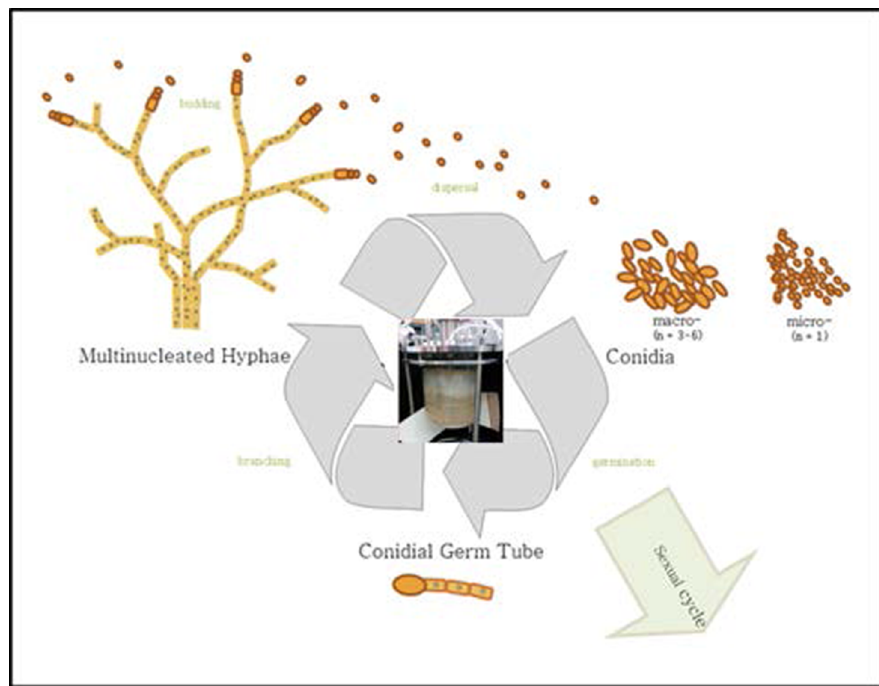
Figure 1. Generalized lifestyle of N. crassa during which different cell types occur. Center image illustrates bioreactor set-up. Within the bioreactors utilized in this study, N. crassa was present as both multi- and uninucleated